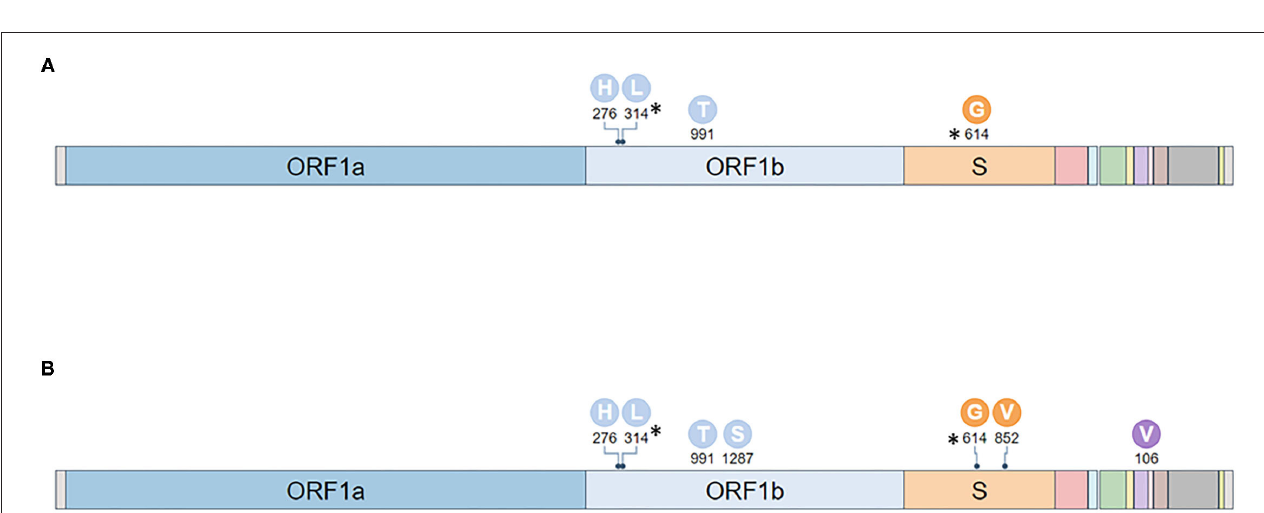
FIGURE 2 | Mutations identified in two specimens analyzed. The mutations identified with a frequency > 61.9% in IZSPB_141 (A) and in IZSPB_123 (B) were reported in the figure. The characteristic mutations of B.1 (identified in at least 75% sequences) were marked with